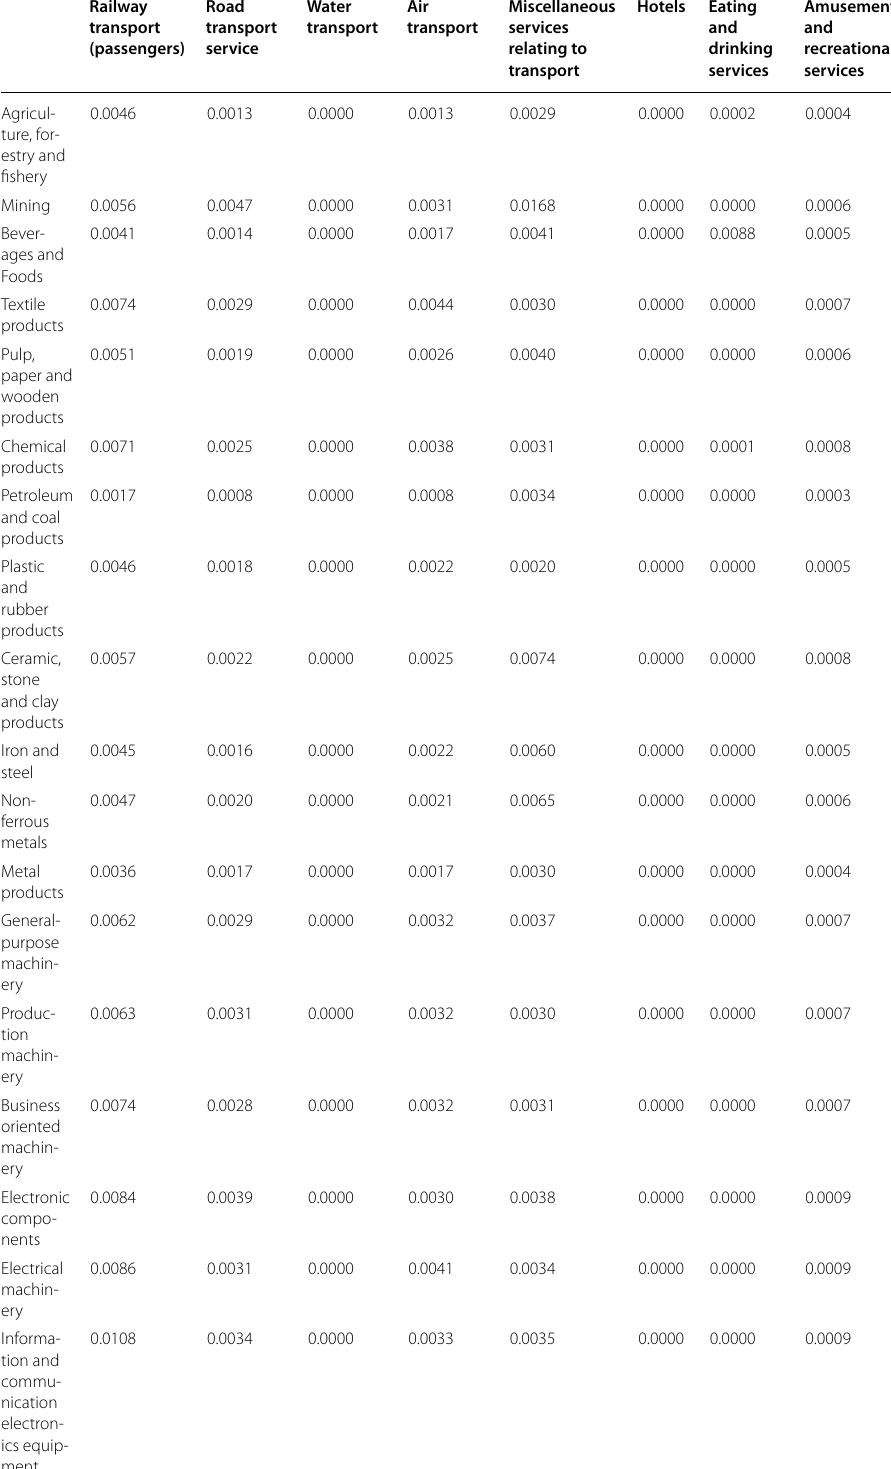
B ′ 1 (cid:30) (cid:31)